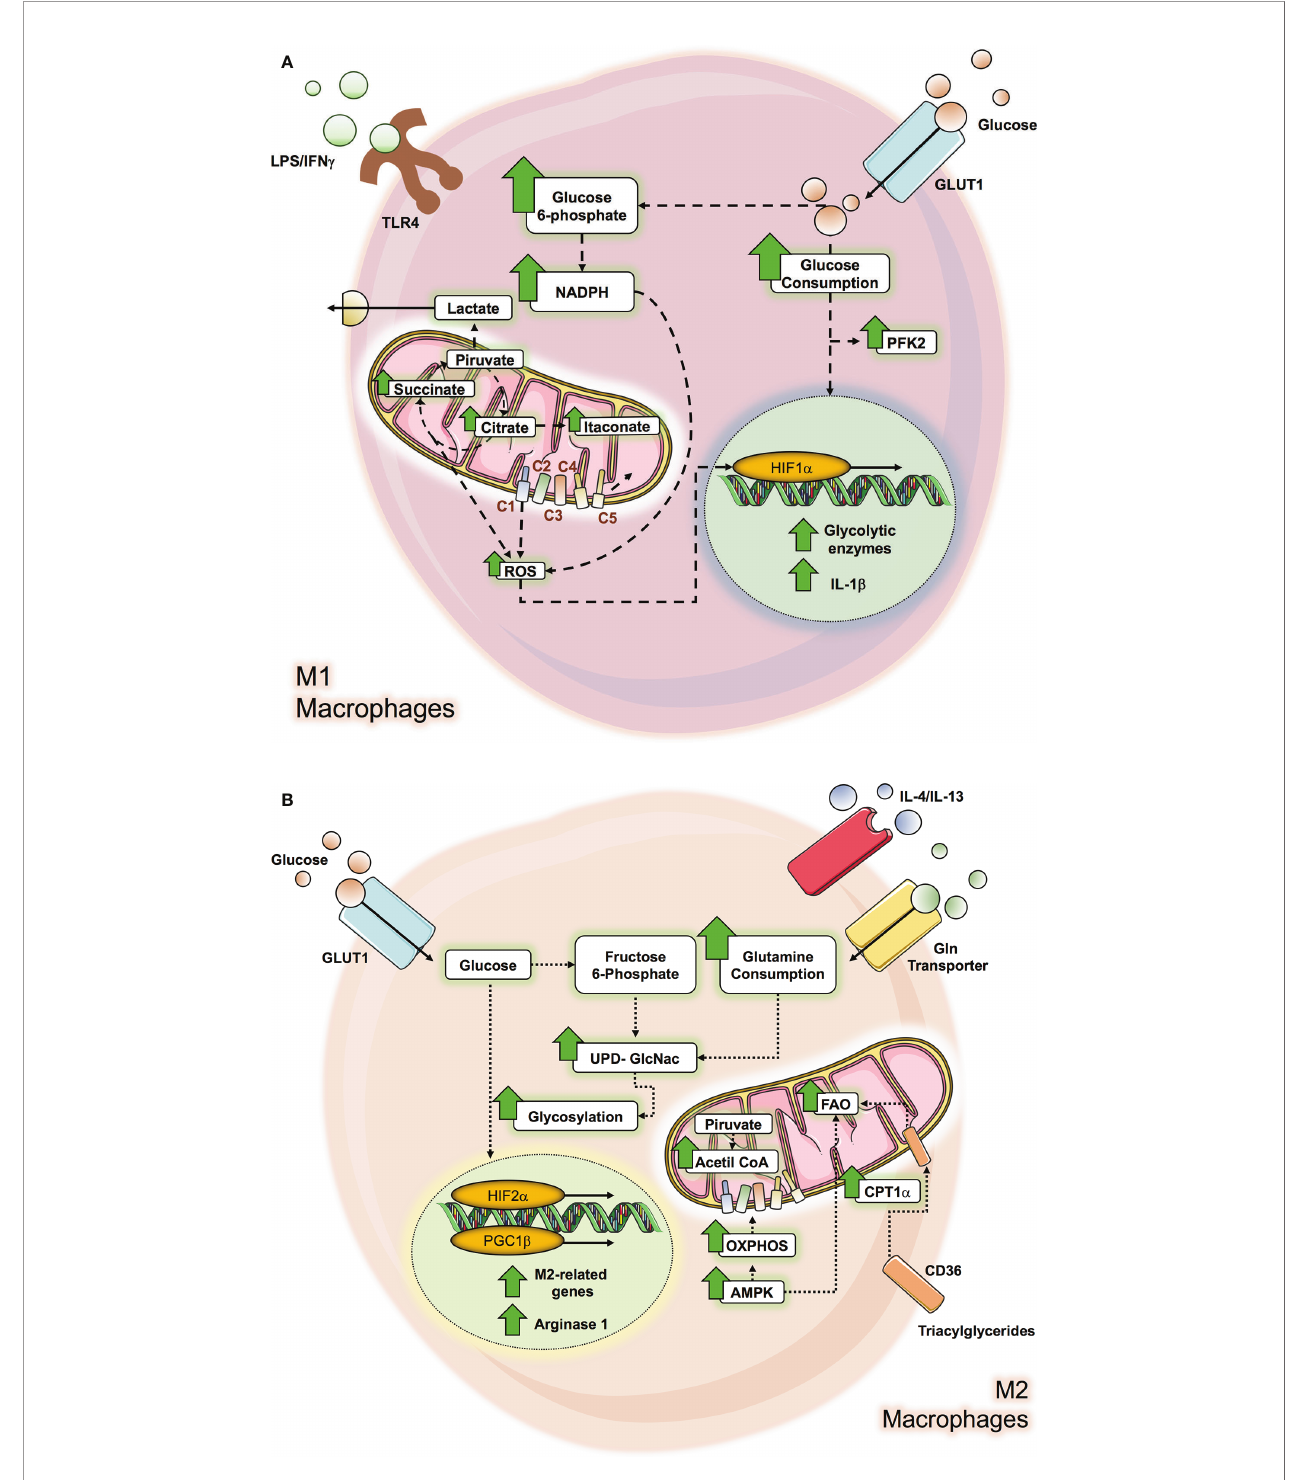
FIGURE 1 | Metabolic pathways altered in M1 and M2 macrophage. macrophage metabolic pathways can be altered by microenvironment molecules as glucose, interleukines and LPS/IFN- g according to the macrophage subtype polarization, where M1 macrophage (A) affected pathways correspond to glycolysis and Krebs cycle while in M2 macrophage (B) , the OXPHOS and the FAO pathways are the ones which can be